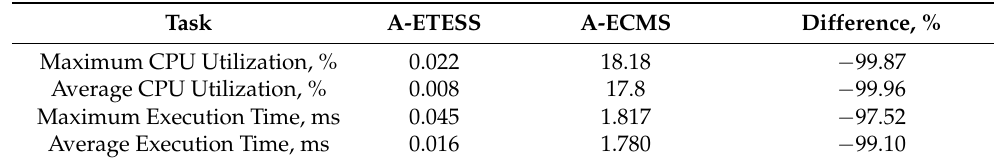
Table 4. PIL testing results for